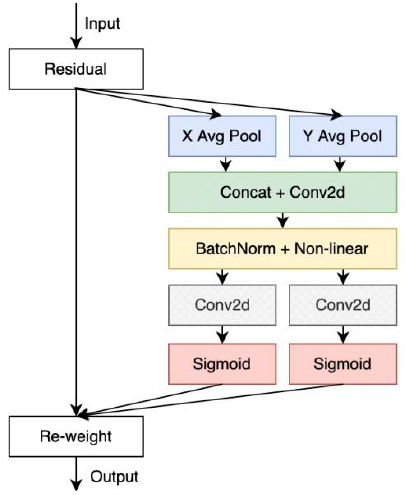
Figure 4. Structure diagram of the coordinate attention mechanism.